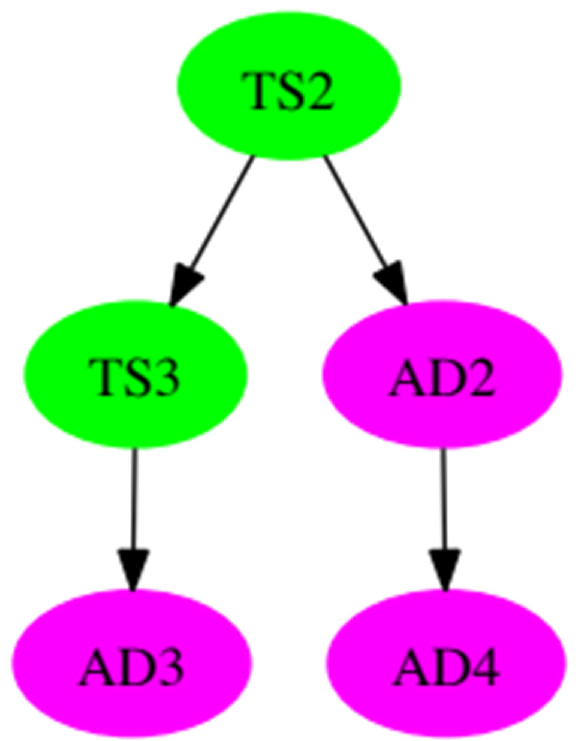
Figure 1. Sequence of batch cultures: TS2 and TS3 cultures on glucose-based medium (green); AD2, AD3, and AD4 cultures on ADH-based medium (purple).